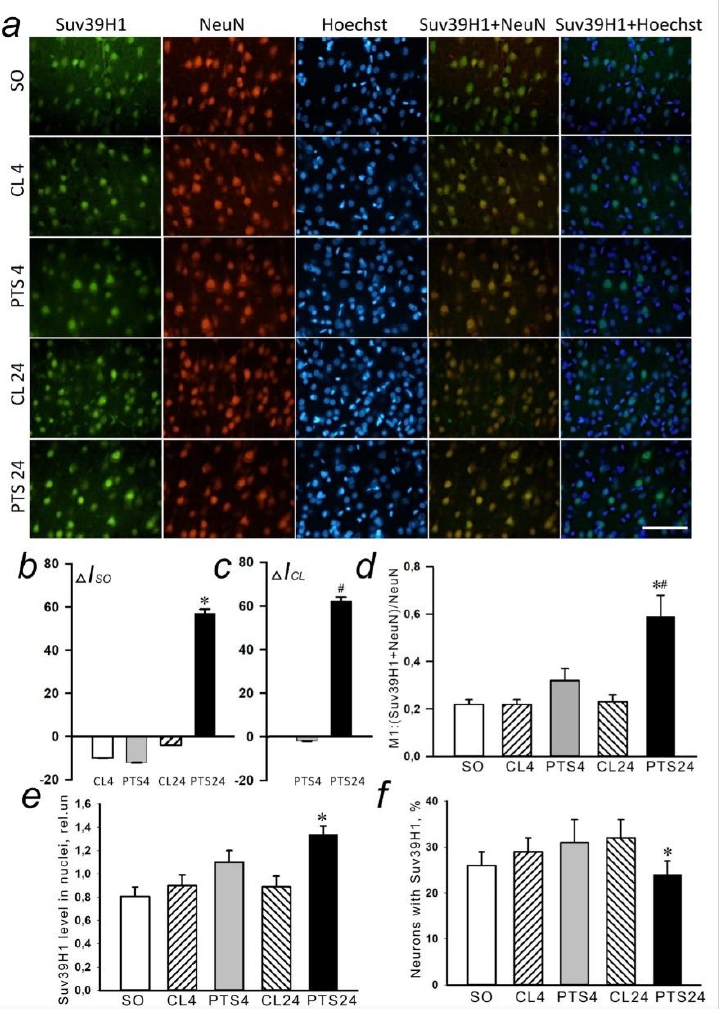
Figure 5. The changes in Suv39H1 localization and levels in the neurons of ischemic penumbra 4 and 24 h after photothrombotic stroke in the rat cerebral cortex. The localisation and level of Suv39H1 are shown at 4 and 24 h after PTS (PTS4 and PTS24, respectively) compared to the contralateral cortex of the same animals (CL4 and CL24), or the cerebral cortex of sham-operated rats (SO). ( a ) Immunofluorescence of Suv39H1 (green), neuronal marker NeuN (red), nuclear chromatin marker Hoechst 33342 (blue), and image overlay. The scale bar is 50 μ m. ( b ). Percent changes ( Δ ISO) of Suv39H1 levels in the penumbra at PTS4 or PTS24 and CL4 or CL24 compared to SO. ( c ) Percent changes ( Δ ICL) of Suv39H1 levels in the penumbra at PTS4 or PTS24 compared to the CL4 or CL24. ( d ) Coefficient M1 of Suv39H1 co-localization with the neuronal marker (NeuN) in different control and experimental groups. ( e ) Immunofluorescence of Suv39H1 in cell nuclei. ( f ) Percentage of cells expressing Suv39H1 per 100 cells stained with Hoechst 33342 * p < 0.05 compared to SO, # p < 0.05 compared to theCL4 or CL24. One Way ANOVA; M ± SEM; n = 7.